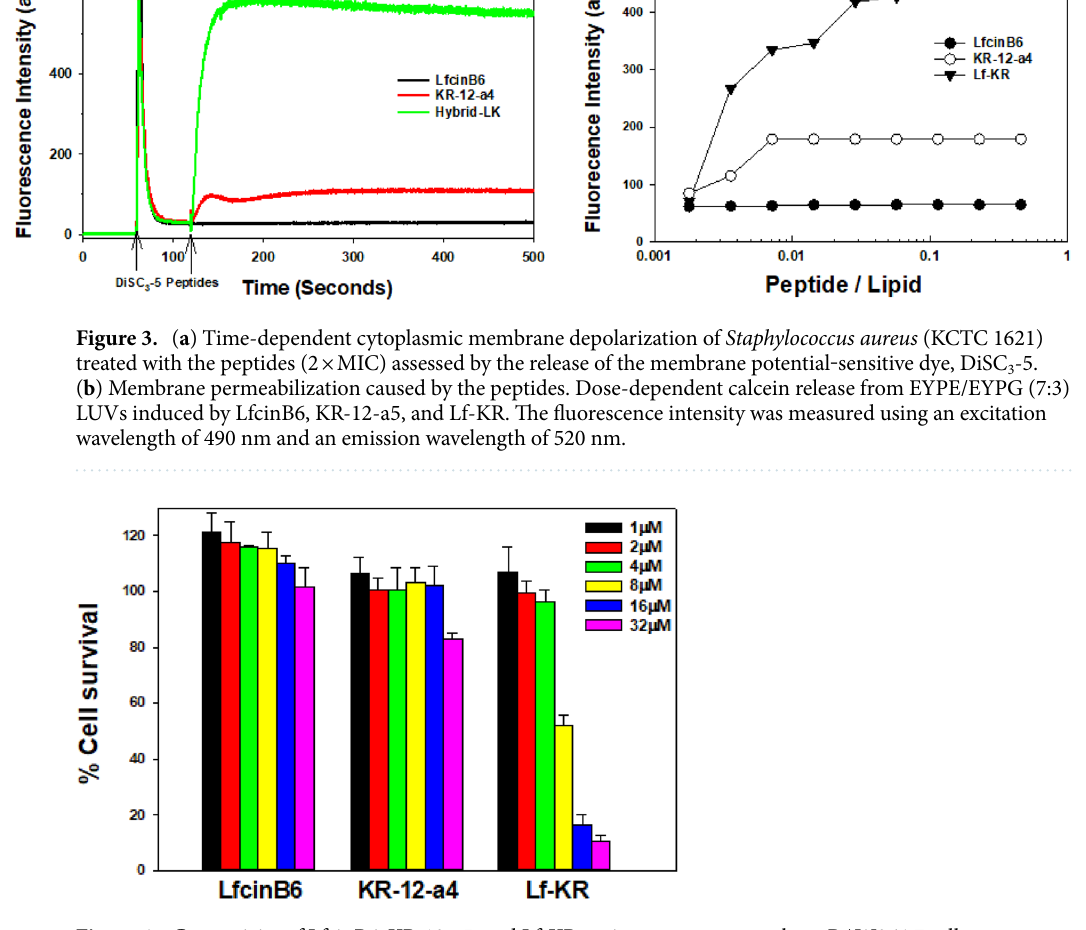
Figure 4. Cytotoxicity of LfcinB6, KR-12-a5, and Lf-KR against mouse macrophage RAW264.7